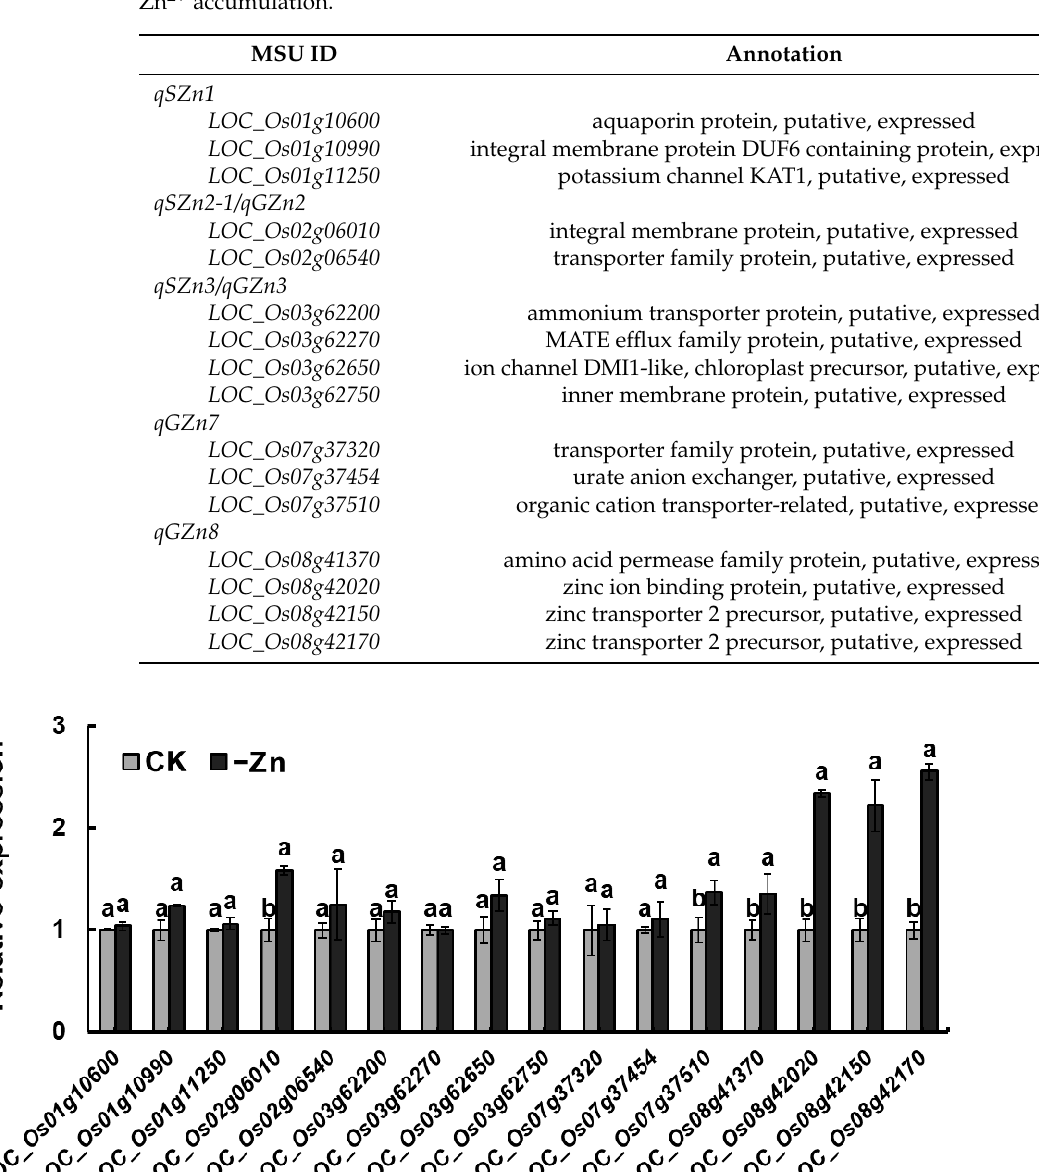
Figure 5. Complementation of the yeast mutant strain ZHY3 by LOC_Os02g06010. ( A ) Overnight yeast cell suspensions of ZHY3 transformed with empty vector pYES2, OsZIP5, or LOC_Os02g06010 were serially diluted (1:10) and spotted onto solid media containing 1, 3 or 100 μ mol/L ZnSO 4 . Pictures were taken after three days growth at 30 °C. Yeast strains were grown in liquid media with ( B ) 3 μ mol/L ZnSO 4 or ( C ) 100 μ mol/L ZnSO 4 for 65 h. The absorbance at 600 nm (OD 600 ) of cell cultures was measured every 5 h. Values are mean ± SE ( n = 3). The asterisks (*) above the bars indicate significant difference between lines at p < 0.01. 3.4. Expression Pattern and Sequence Analysis of LOC_Os02g06010 in Parental Lines The difference of LOC_Os02g06010 in the four parental lines was amplified by PCR and sequenced. The coding region sequence of LOC_Os02g06010 showed no difference between the four parental lines (Figure 6A). The sequence in the 2000 bp region of the upstream of the ATG and the 3’-UTR sequence after the TGA of LOC_Os02g06010 were identical between A, B, and C (Figure 6A). However, D had four single-nucleotide muta- tions in the first intron, three single-nucleotide mutations in the second intron, and one single-nucleotide mutation in the 3’-UTR (Figure 6A).